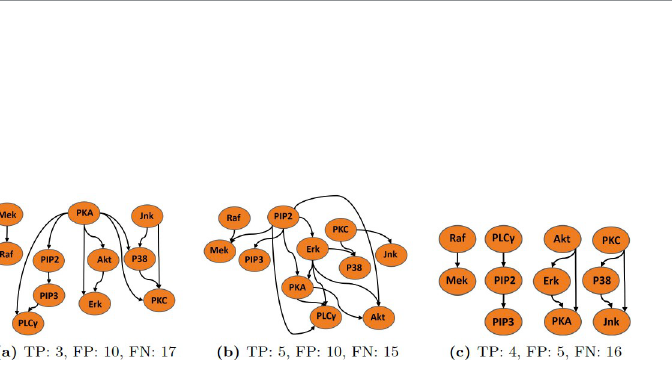
Fig 4. Networks inferred by (a) pooling data from two observational experiments; (b) pooling data from an observational (anti-CD3/CD28) and an interventional experiment (AKT inhibitor); and (c) our method “Learn and Vote” analysed on the same experiments as in the middle panel (b). The metrics used for structure learning evaluation are True Positive (TP), False Positive (FP) and False Negative (FN). False positives are reduced by avoiding